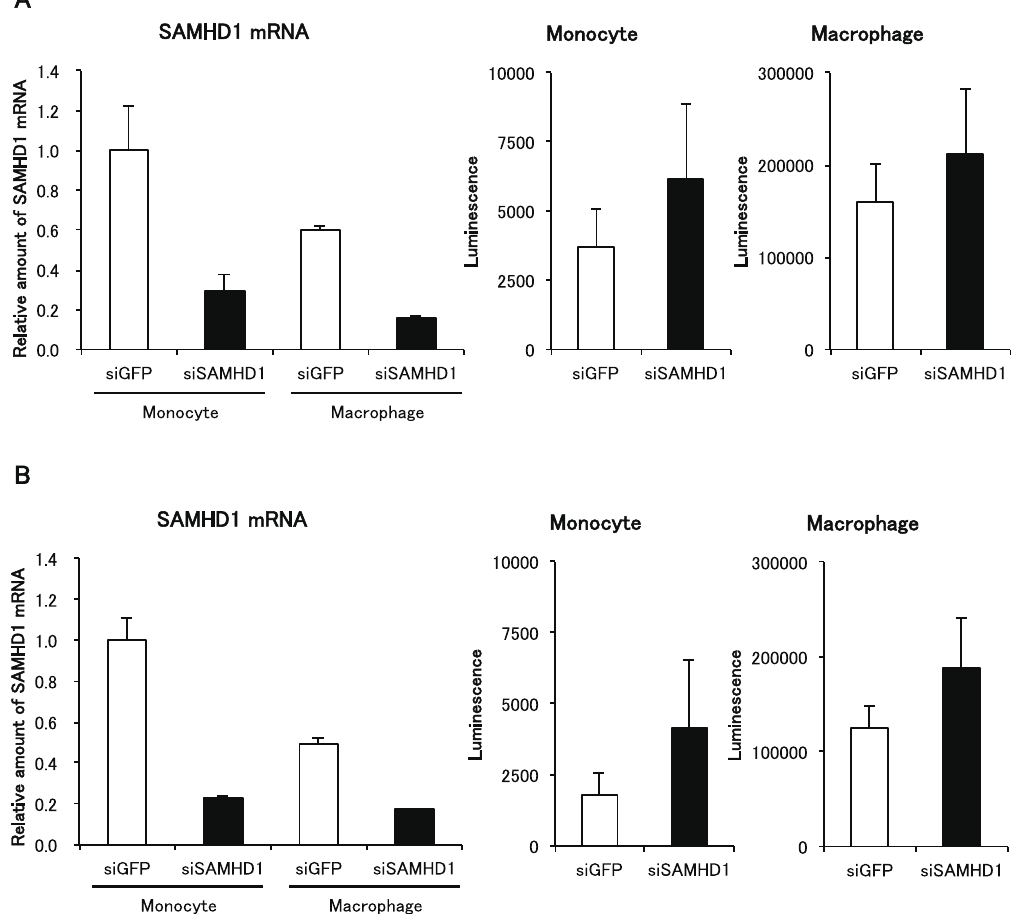
Figure 9. Effects of SAMHD1 siRNA on HIV-1 infection. Monocytes (Monocyte) or macrophages (Macrophage) were treated with SAMHD1- (siSAMHD1) or GFP- (siGFP) targeting siRNAs. Three days after transfection, cells were harvested or infected with NL43-Luci/VSV-G virus. SAMHD1 mRNA expression levels in harvested cells were detected by real-time RT-PCR and normalized against GAPDH. Data are shown as mean 6 SD. Luciferase activity in infected cells was measured 4 days after infection. Data are plotted as the mean 6 SD of triplicate samples; presented data are representative of two independent experiments using two donors. A: Results of samples obtained from a donor 1. B: Results of samples obtained from a donor